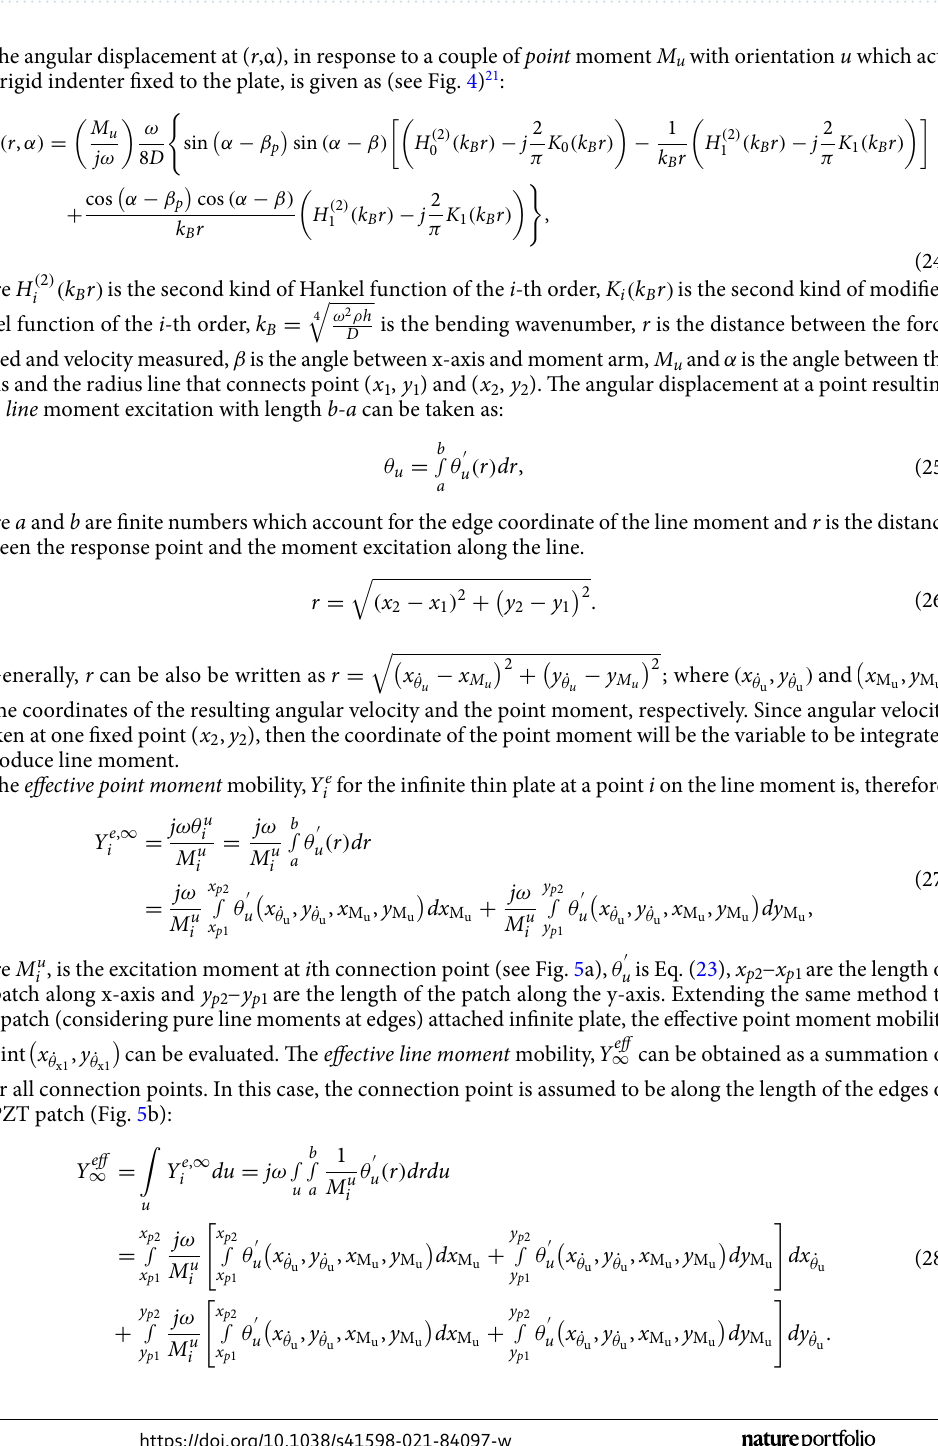
Figure 4. Illustrations of sign conventions for resulting angular velocity at point ( x 2 , y 2 ) subjected by a point moment excitation at ( x 1 , y 1 ) 7